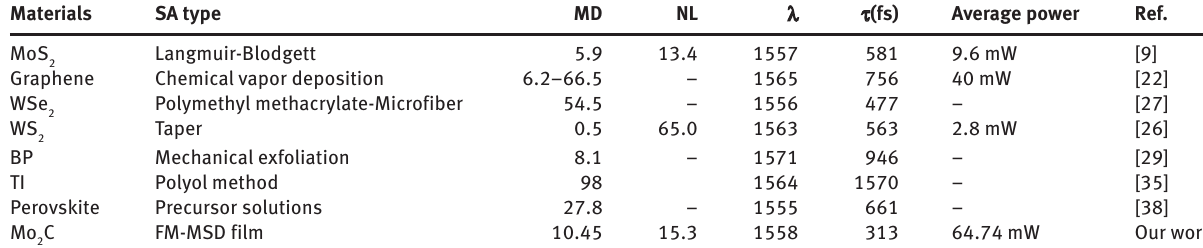
Table 1: Output performance comparison of 1.55 μ m mode-locked fiber lasers using various 2D-material-based SAs.